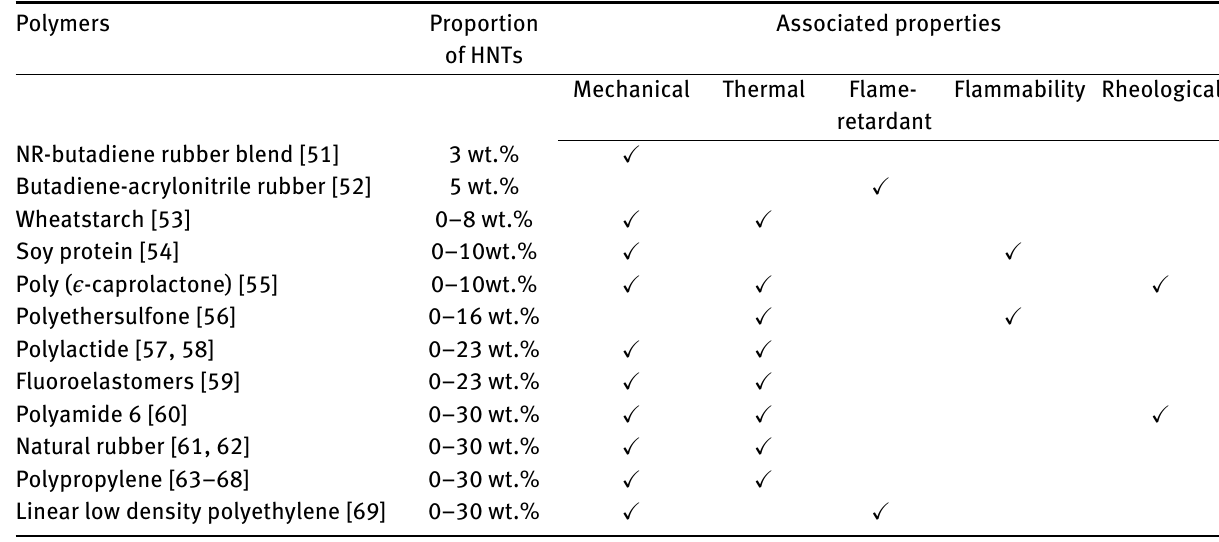
Table 1: HNTs-polymer nanocomposites prepared by melt processing and the main properties enhancement [8] Polymers Proportion